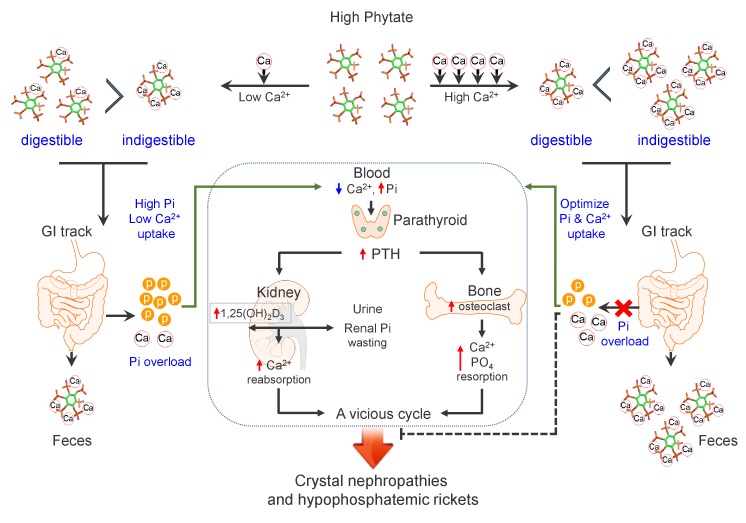
Model for the effects of phytate diets supplemented with low-Ca2+ or high-Ca2+ on Ca2+ and phosphate homeostasis.In the presence of a low-Ca2+ diet (Ca2+/phytate <5), phytate can adversely affect Ca2+ and phosphate homeostasis in normal healthy rats by inhibiting intestinal Ca2+ absorption while increasing phosphate overload through phytate hydrolysis in the intestine. These effects lead to crystal nephropathies, severe renal phosphate wasting, and pathologic bone loss via increased PTH and 1,25(OH)2D3. By contrast, in the presence of a high-Ca2+ diet, phytate forms multiple Ca2+-phytate salts, which makes them indigestible and unabsorbable in vivo, leading to their excretion in the feces as undigested Ca2+-phytate salts. This process prevents a vicious cycle of intestinal phosphate overloading and renal phosphate wasting while improving intestinal Ca2+ bioavailability, which eventually alleviates the detrimental effects of excess phytate hydrolysis.